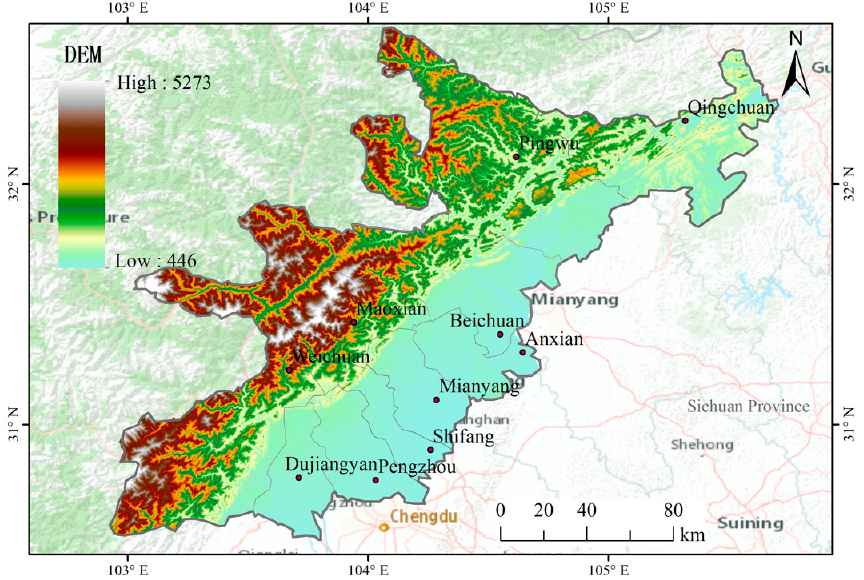
Figure 1. Topographic map of Wenchuan epicenter area.